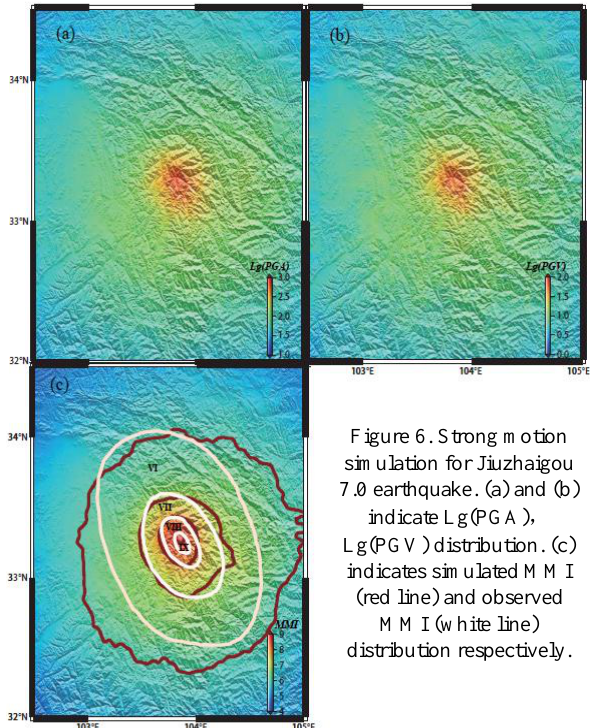
Figure 6. Strong motion simulation for Jiuzhaigou 7.0 earthquake. (a) and (b) indicate Lg(PGA) ， Lg(PGV) distribution. (c) indicates simulated MMI (red line) and observed MMI (white line) distribution